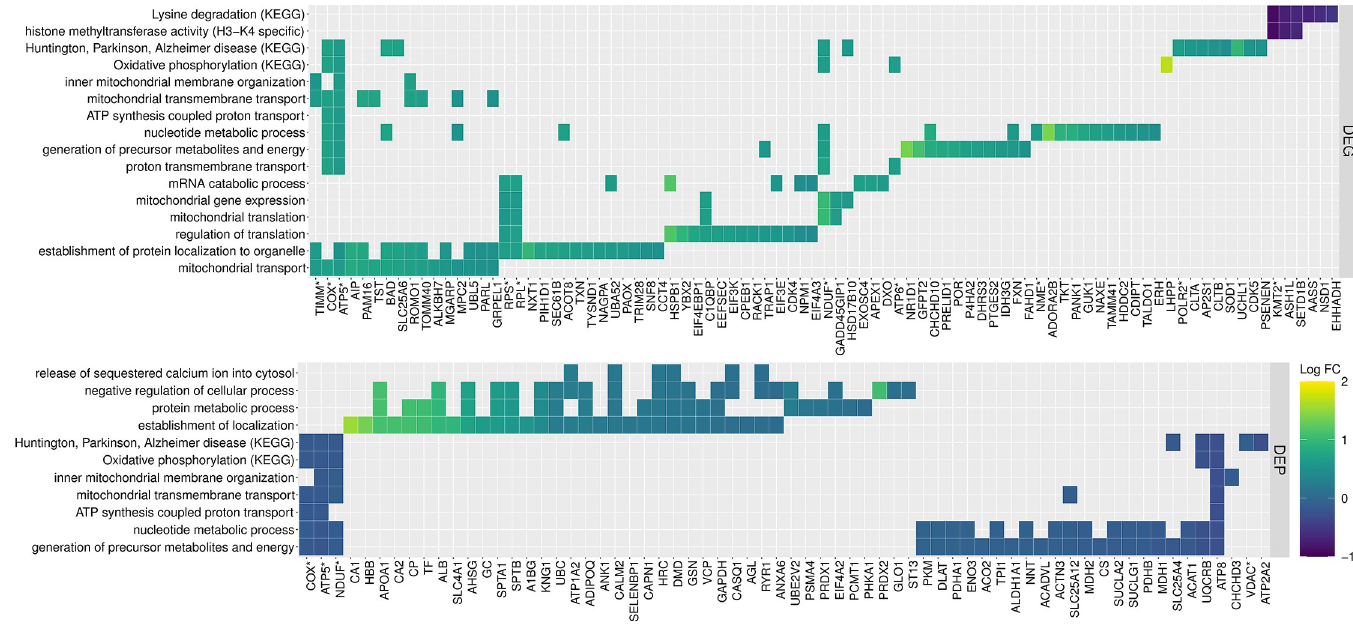
Fig 5. Heatmap illustrating the individual DEG and DEP found within enriched GO and KEGG pathways. Darker colors indicate lower log 2 fold change difference in gene or protein expression in RER-susceptible compared to control